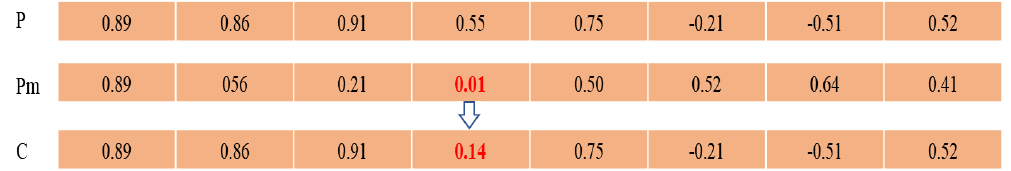
Figure 6. Mutation, Gaussian operator. P is the elected parent, Pm is the mutation probability, and C is the generated child.